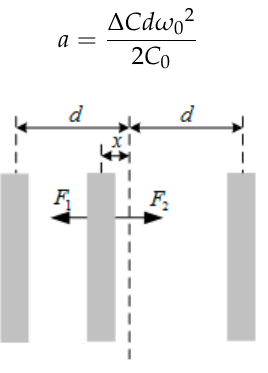
Figure 2. Differential capacitance model of the sensitive element.